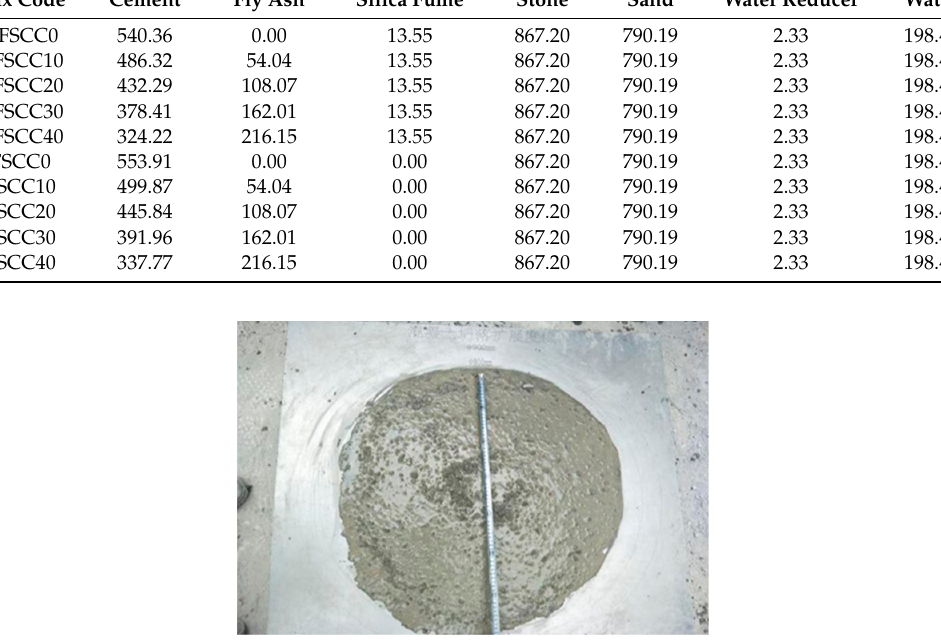
Figure 2. The Extent of Self-compacting Concrete (SCC ) .